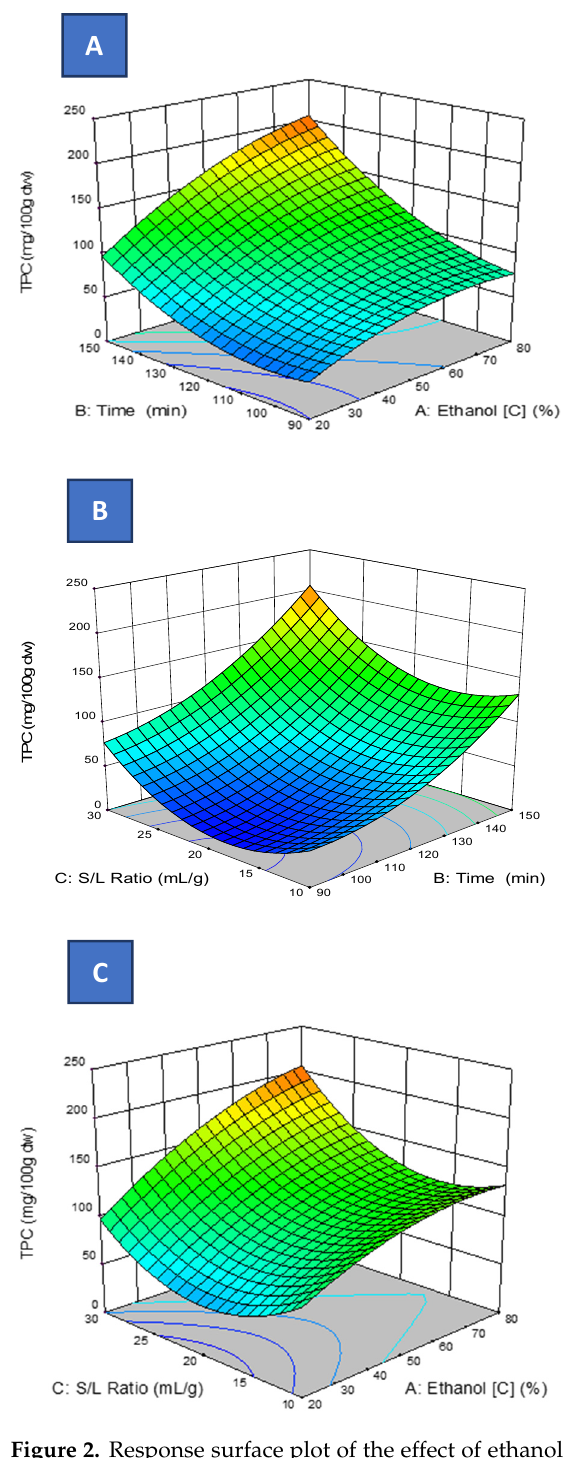
Figure 2. Response surface plot of the effect of ethanol concentration (%, v/v ) and extraction time (min) ( A ), ethanol concentration (%, v/v ) and liquid/solid ratio (mL/g) ( B ) and extraction time (min) and liquid/solid ratio (mL/g) ( C ) on the TPC of the PP extract. According to Amado et al. [43], the optimal TPC from PP was achieved at 34 min using an ethanol concentration of 71.2%. Paleologou et al. [9] described water/ethanol